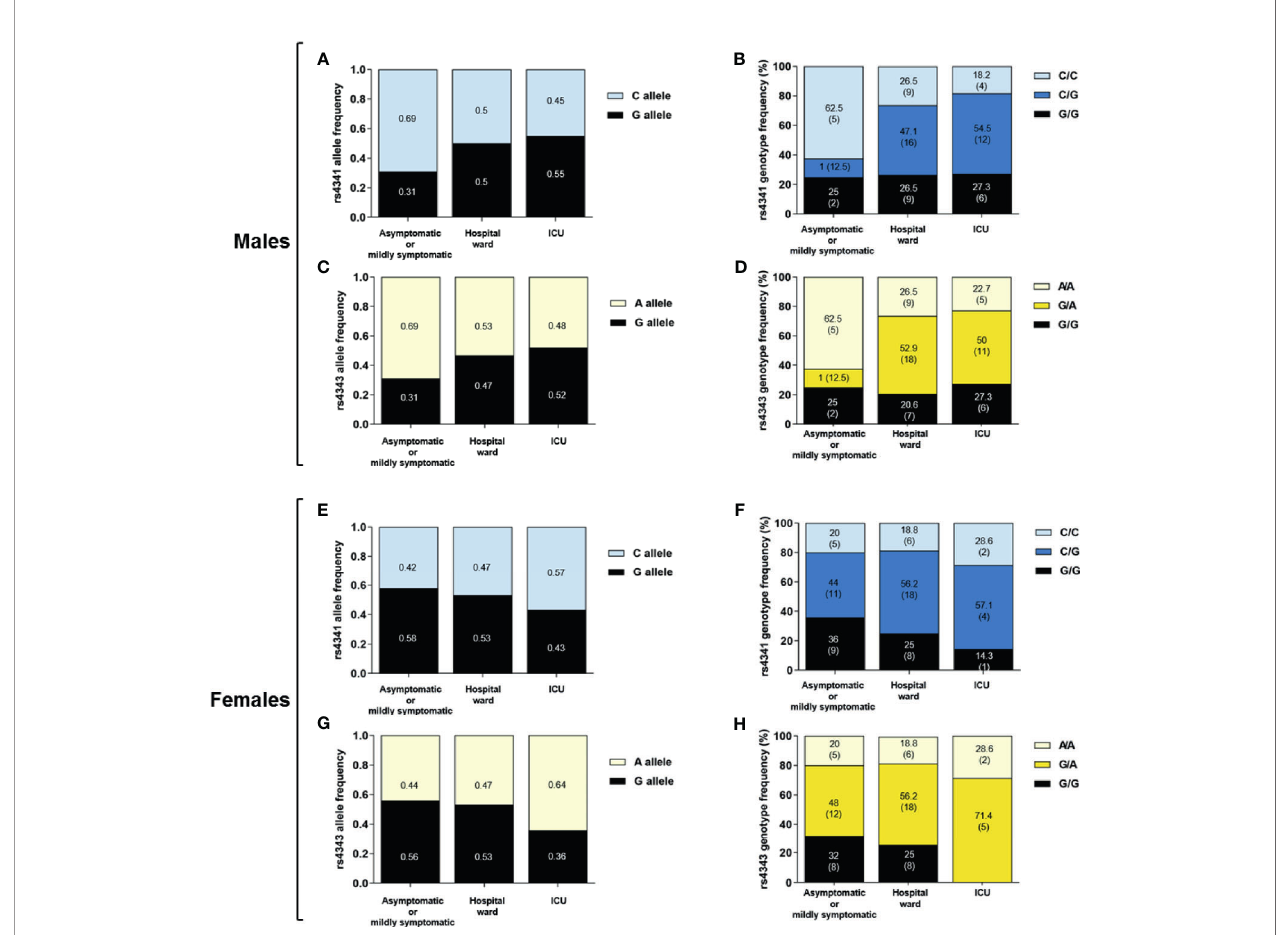
FIGURE 2 | Allele and genotype distribution of the rs4341 and rs4343 polymorphisms among SARS-CoV-2 infected male and female. Allele frequencies of rs4341 and rs4343 polymorphisms among SARS-CoV-2 infected males (A, C) and females (E, G) . Data are presented as proportions. Genotype frequencies of rs4341 and rs4343 polymorphisms among SARS-CoV-2 infected males (B, D) and females (F, H) . Data are presented as percentages. The number of patients is indicated in brackets. All data were adjusted for